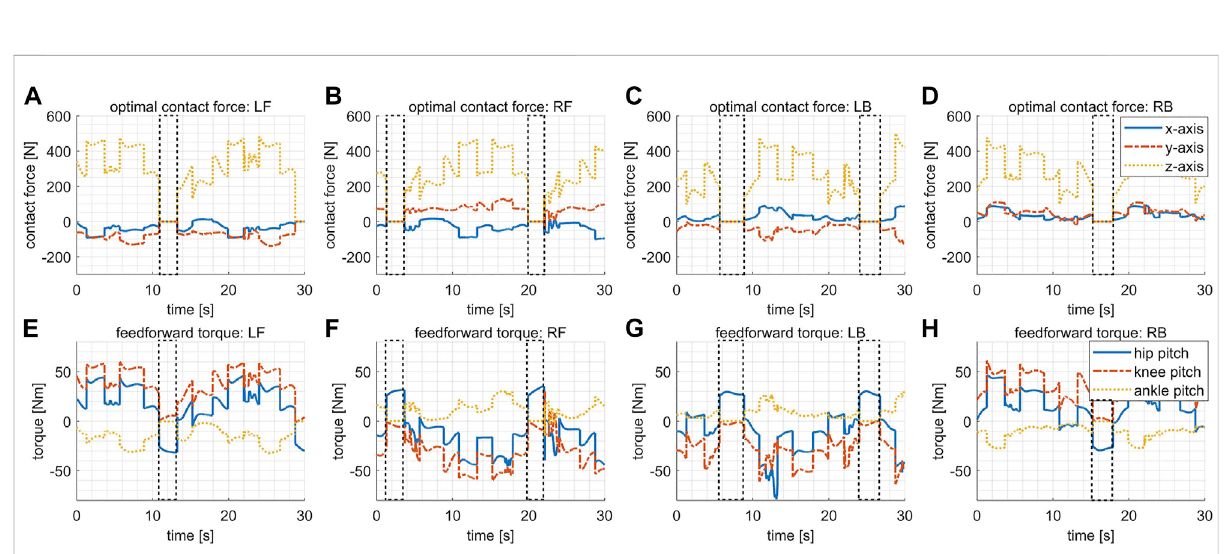
FIGURE 6 The desired contact forces and the feedforward torques in the variable stiffness locomotion. The dashed boxes indicate the periods when the corresponding leg is in swing. (A) The desired contact force for the leg LF. (B) The desired contact force for the leg RF. (C) The desired contact force for the leg LB. (D) The desired contact force for the leg RB. (E) The feedforward torques for the leg LF. (F) The feedforward torques for the leg RF. (G) The feedforward torques for the leg LB. (H) The feedforward torques for the leg